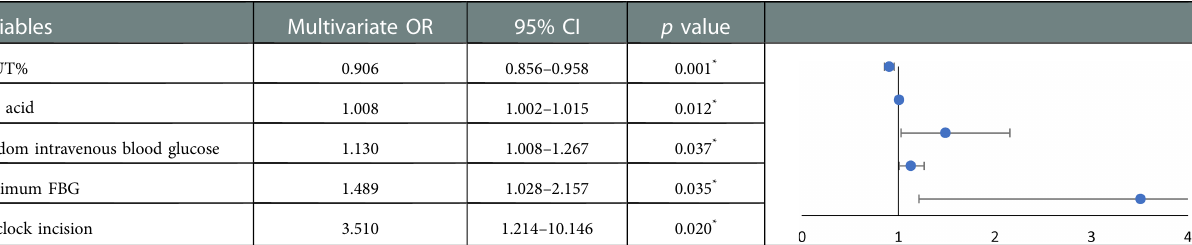
TABLE 6 Multivariate regression analysis for relevant variables.